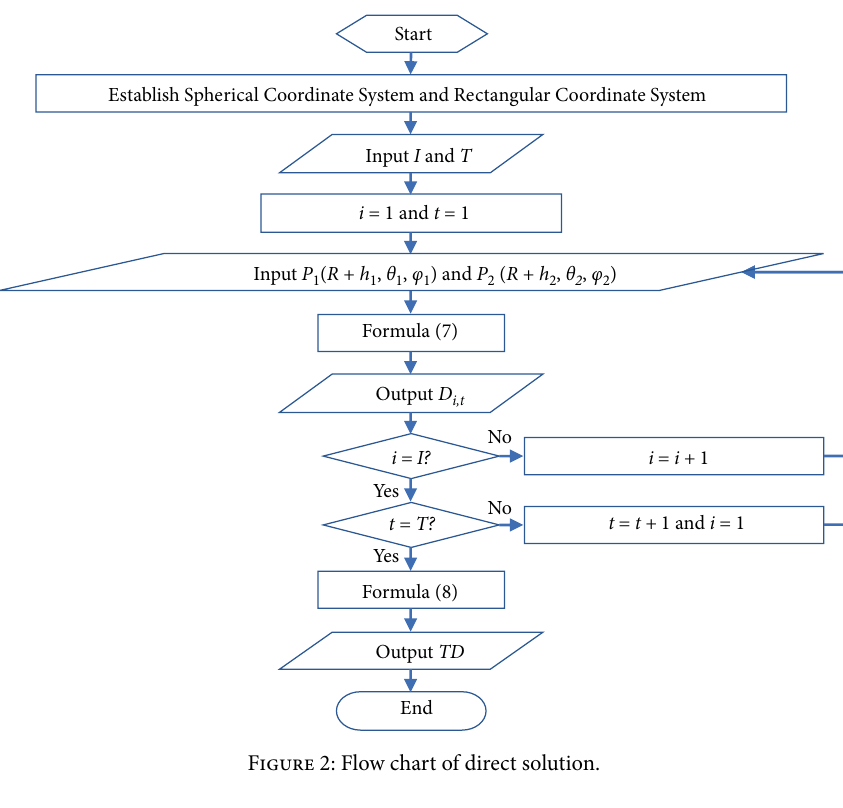
Figure 2: Flow chart of direct